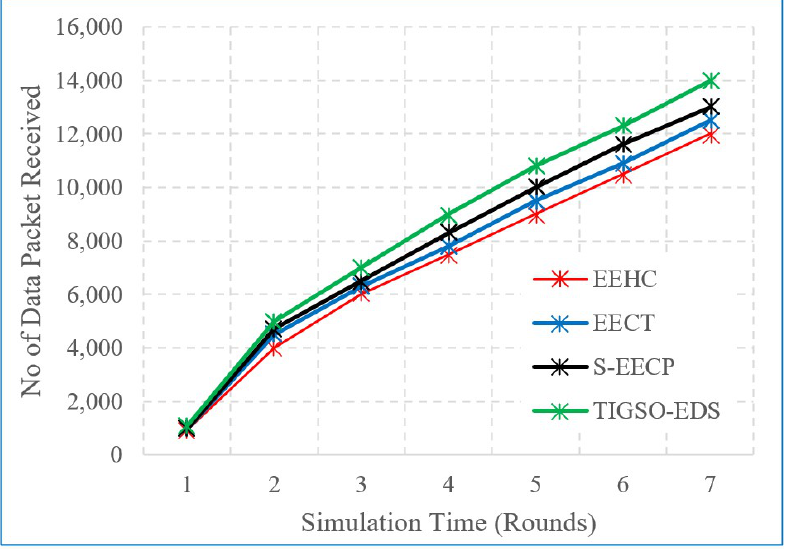
Figure 7. Comparison of data packets received at the base station (BS) located at 100 ×